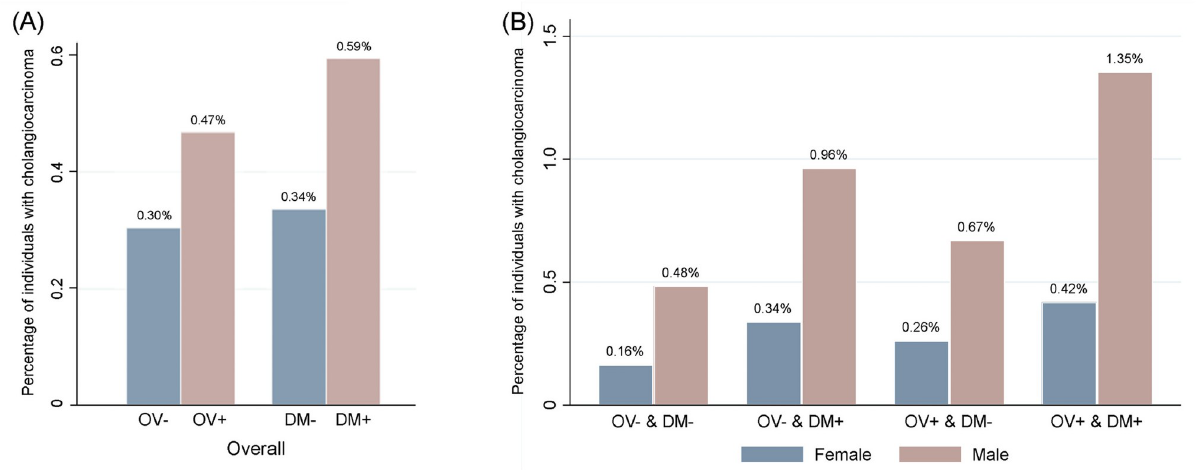
Fig 4. Percentages of individuals with cholangiocarcinoma in relation to O . viverrini infection and diabetes mellitus status overall (A) and according to gender (B). Data show the rate of cholangiocarcinoma as percentage for overall O . viverrini infection and diabetes mellitus groups, and combination of O . viverrini infection and diabetes mellitus separated by sex.